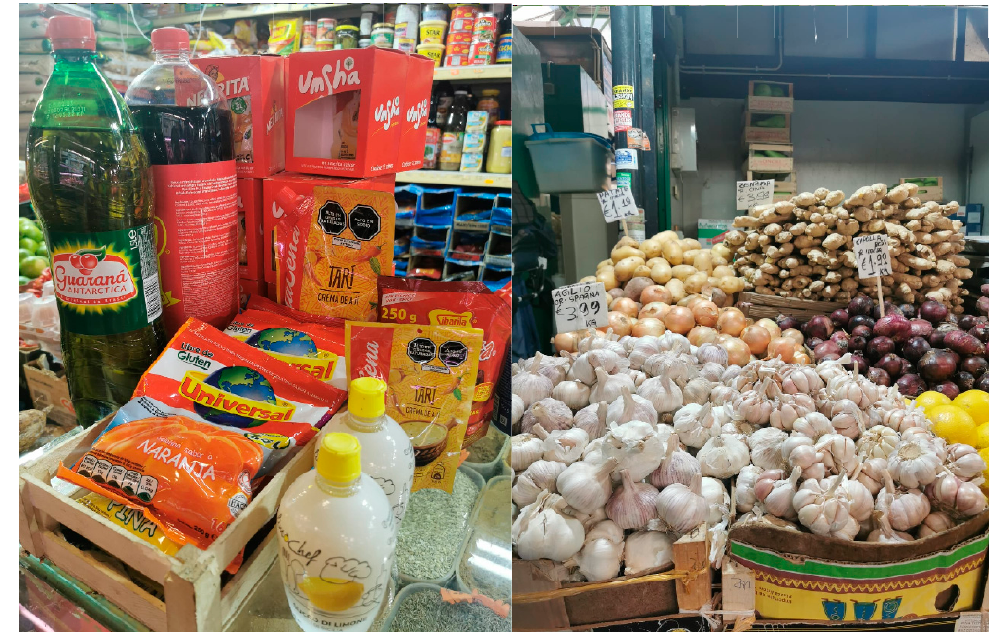
Figure 4. Examples of the goods sold by Bangladeshi food stands. (2 August 2022). © Sharon Men-